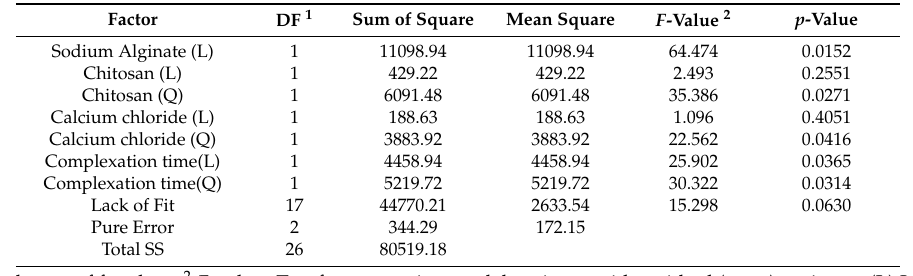
Table 4. Analysis of variance (ANOVA) for central composite rotatable design (CCRD) for Immobilized Lipase